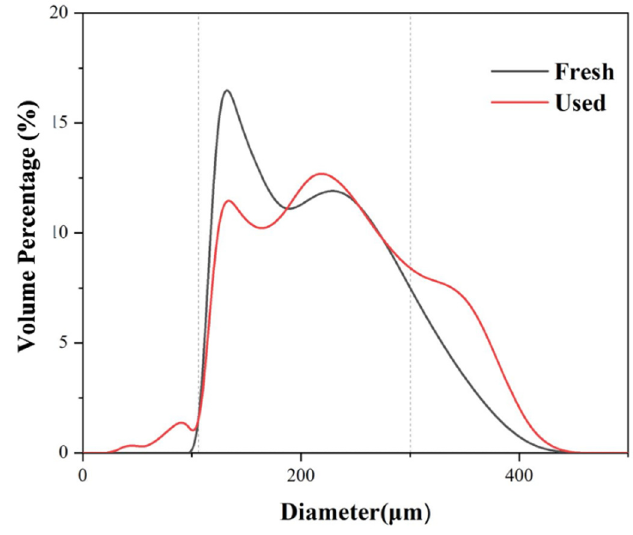
Figure 16. Particle size distributions of the fresh and used CA70-bonded oxygen carriers.